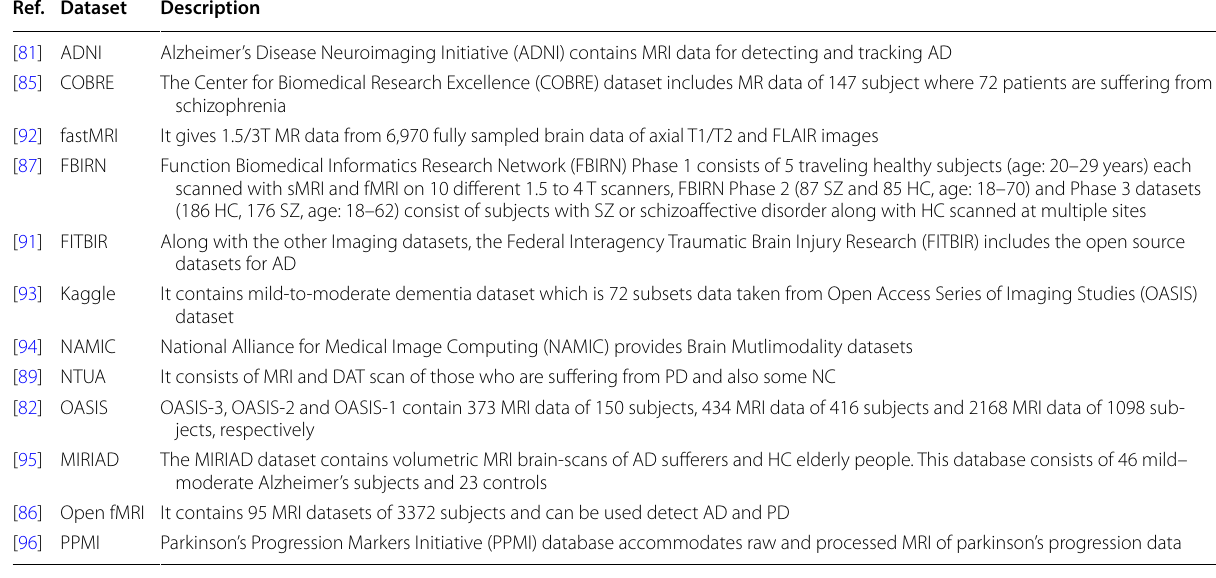
Table 5 Open source datasets containing data of neurodegenerative disorders Ref.